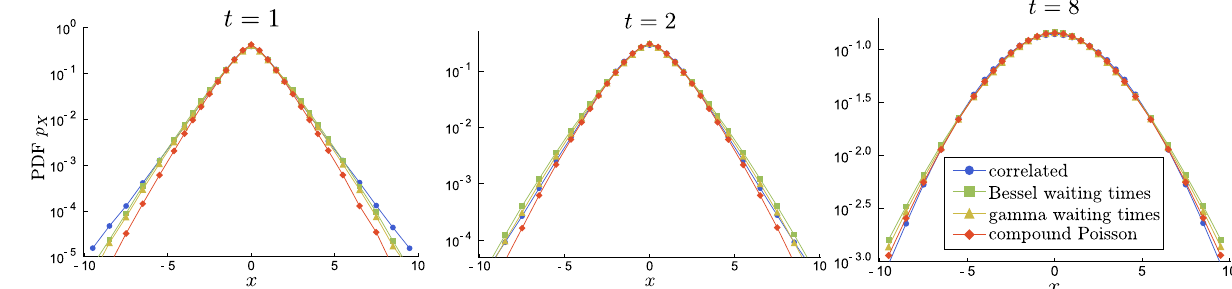
Figure 10. Comparison of the correlated CTRW and further approximations. Bessel and gamma waiting times CTRWs are nearly undistinguishable, all others are also close. These random walks have the same Gaussian 8 . Due to using non-dimensional time in CTRW approximations, the plots here limit, as shown for t = correspond to the same time regimes as in Fig.